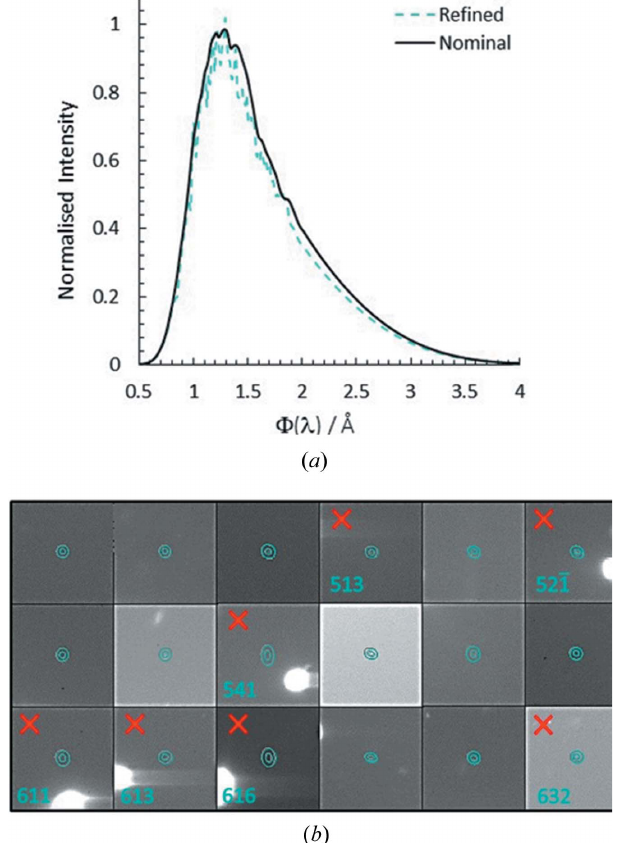
Figure 5 ( a ) Refined instrument wavelength spectrum for Laue data collected at 0.71 GPa for copper sulfate pentahydrate. The nominal spectrum is included for comparison. ( b ) Selected set of outliers produced during the normalization process, the red crosses indicating the sample Laue spots rejected manually given their proximity to diamond reflections or diamond